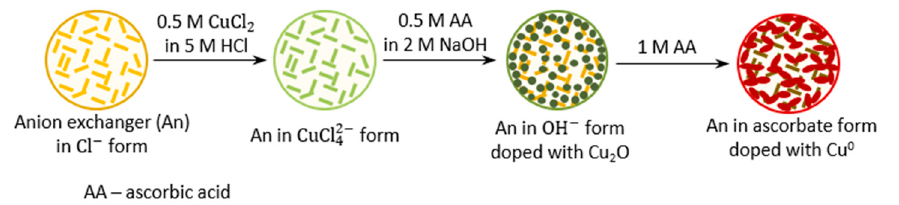
Table 1. Reducer solutions.